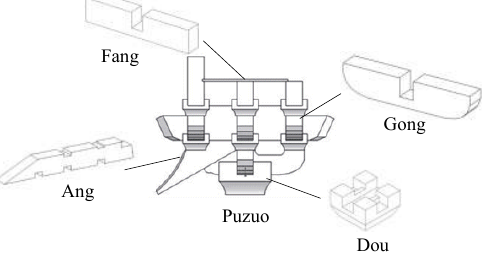
Figure 1. Schematic diagram of a Dou-Gong.